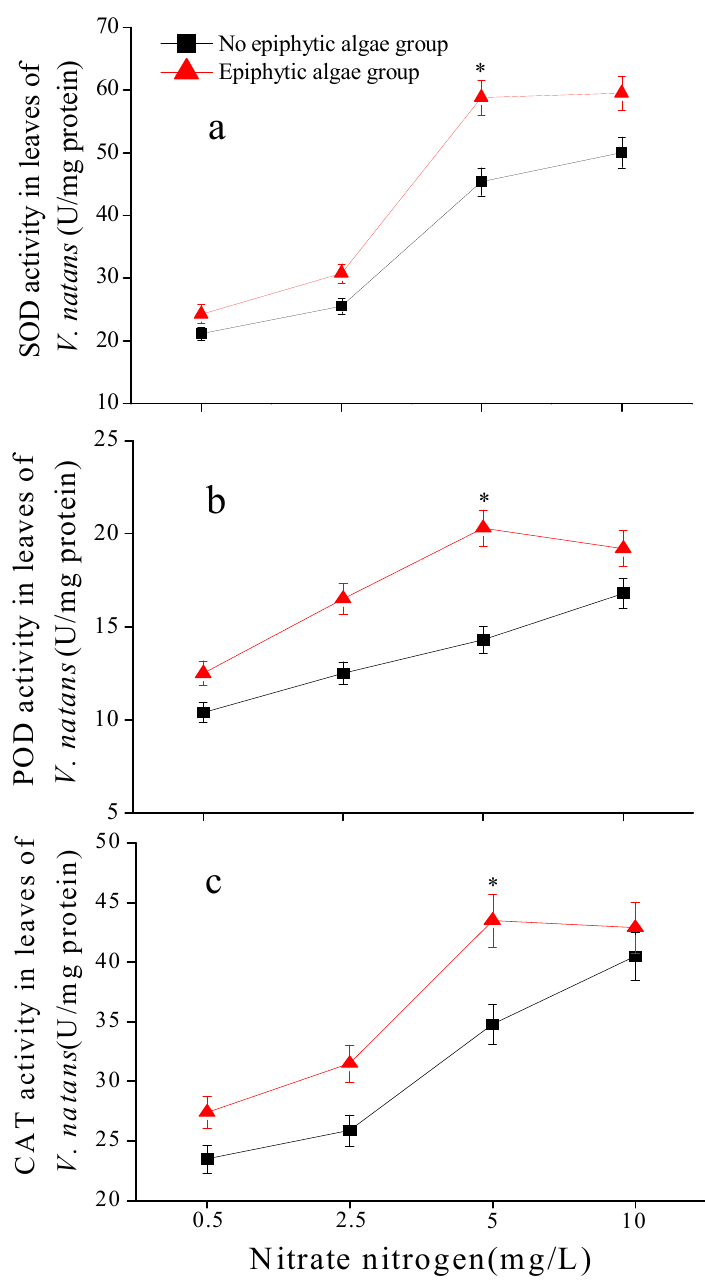
Figure 6. Antioxidant enzyme activity (POD, SOD, CAT) in leaves of V. natans (mean ± SE, n = 3) in the epiphytic algae group and no epiphytic algae group under four nitrate-N concentrations. Subfigures ( a – c ) represent the antioxidant enzyme activities of POD, SOD, and CAT, respectively. Bars with a “*” sign show a significant difference between two epiphytic algae statuses ( p < 0.01).